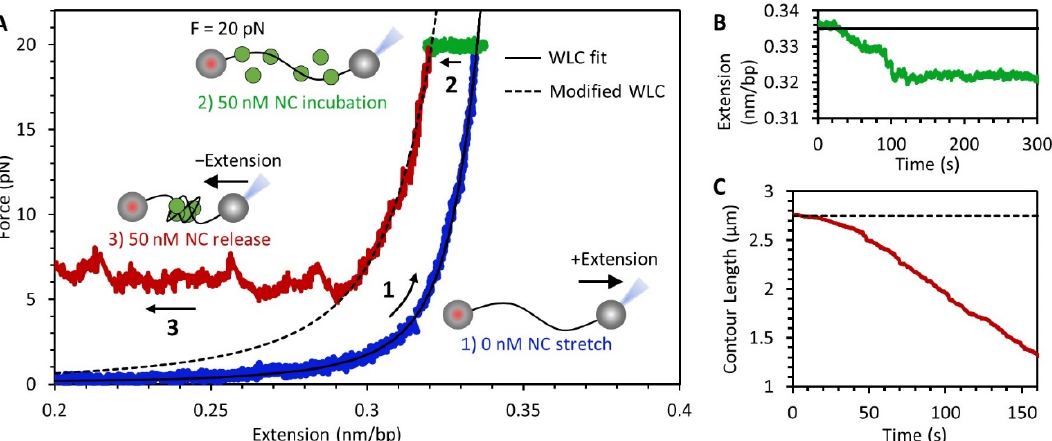
Figure 3. NC-mediated compaction of DNA. ( A ) DNA force-extension curve showing results of an experiment performed in three steps. (1, blue) An 8.1 kbp DNA, biotinylated on both ends, is tethered between two streptavidin coated beads. One bead is held in a stationary dual-beam optical trap while the other is moved using a piezo-electric stage attached to a micropipette tip in order to extend the DNA. Stretching of protein-free DNA follows the idealized polymer WLC model (black line fit to blue data). (2, green) While the DNA is held at a constant tension of 20 pN, a fixed concentration of NC is flowed into the sample and incubated with the DNA. Binding of the NC to the substrate results in a small decrease in extension. (3, red) The extension of the DNA is reduced, initially resulting in a decrease in tension, consistent with the WLC model with modified contour and persistence length (dashed line). Once a critical force is reached, however, the DNA continues to compact without a drop in tension, resulting in a force plateau. ( B ) Plot of DNA extension during protein incubation while holding at a constant 20 pN (green data and black fit line from panel ( A )). ( C ) Contour length of uncondensed DNA during NC mediated compaction including force plateau (red data and dashed fit line from panel ( A